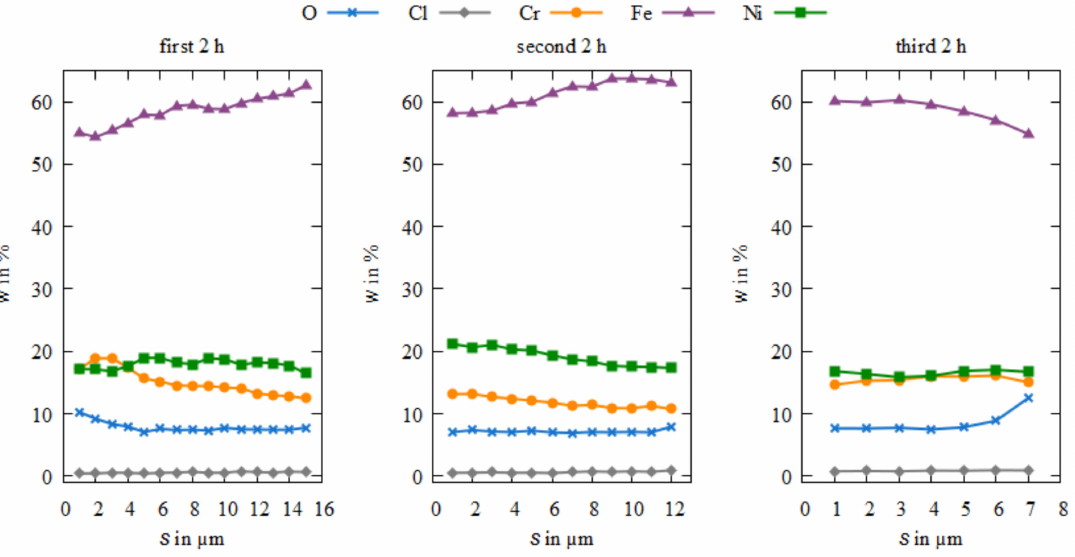
Figure 16. EDXS measurement of alloy compositions over the entire layer thickness of the PC samples depending on the electrolyte